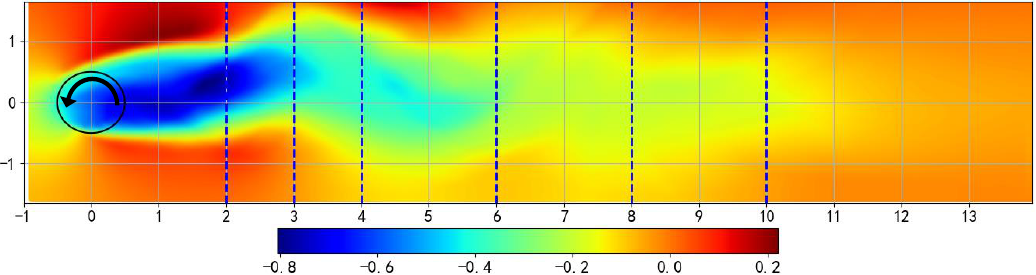
Figure 8. The time-average velocity field of the VAWT wake. The X-axis is the streamwise position, which is normalized by the turbine diameter ( X/D ). The Y-axis is the lateral position, which is normalized by the turbine diameter ( Y/D ). The color bar is the velocity deficit, which is normalized by the inflow velocity (Δ U/U 0 ). The blue dashed lines indicate that the velocity profiles at that location are used for comparison with the PIV experimental results.